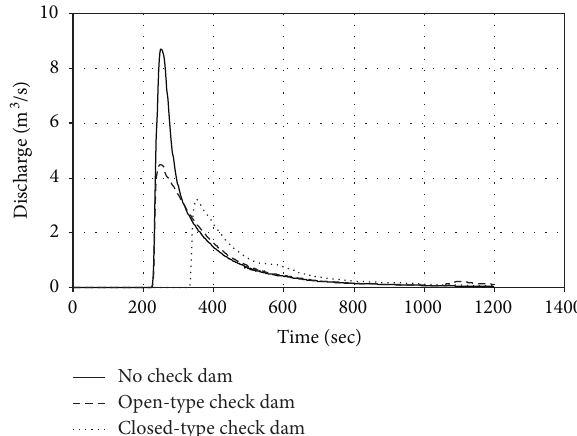
Figure 11: Observation point 1 with or without a check dam and debris flow rates comparison between the check dam types.